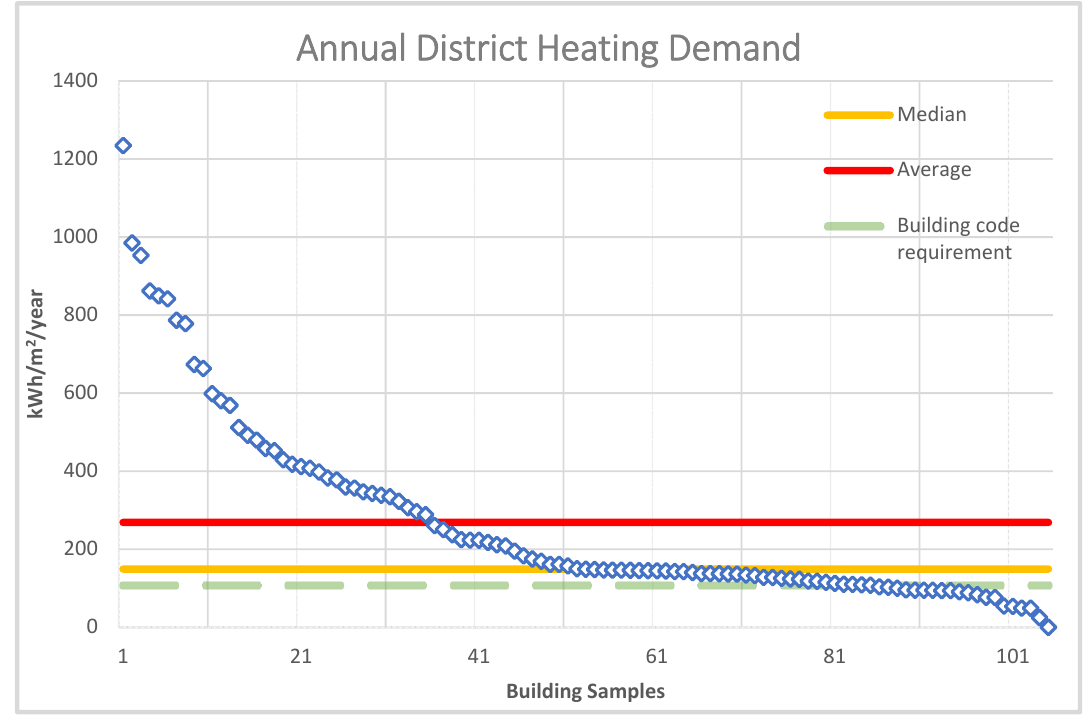
Figure 5. Annual heating demand for building samples.